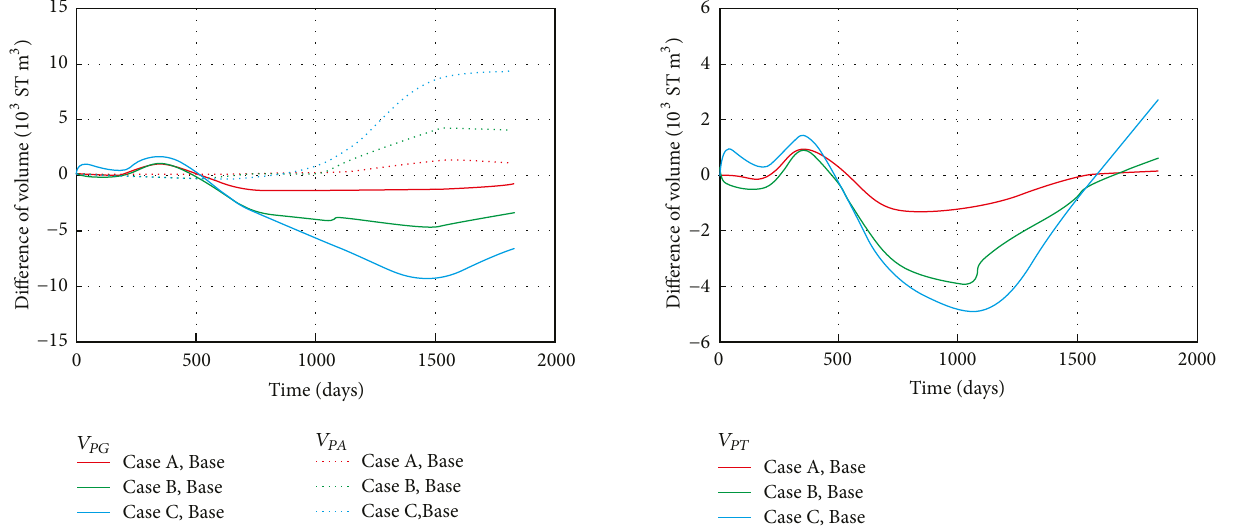
Figure 11: The difference of the cumulative volume of total methane gas produced at the well ( 𝑉 𝑃𝑇 ) between horizontal strata and those sloping formations over 5-year production